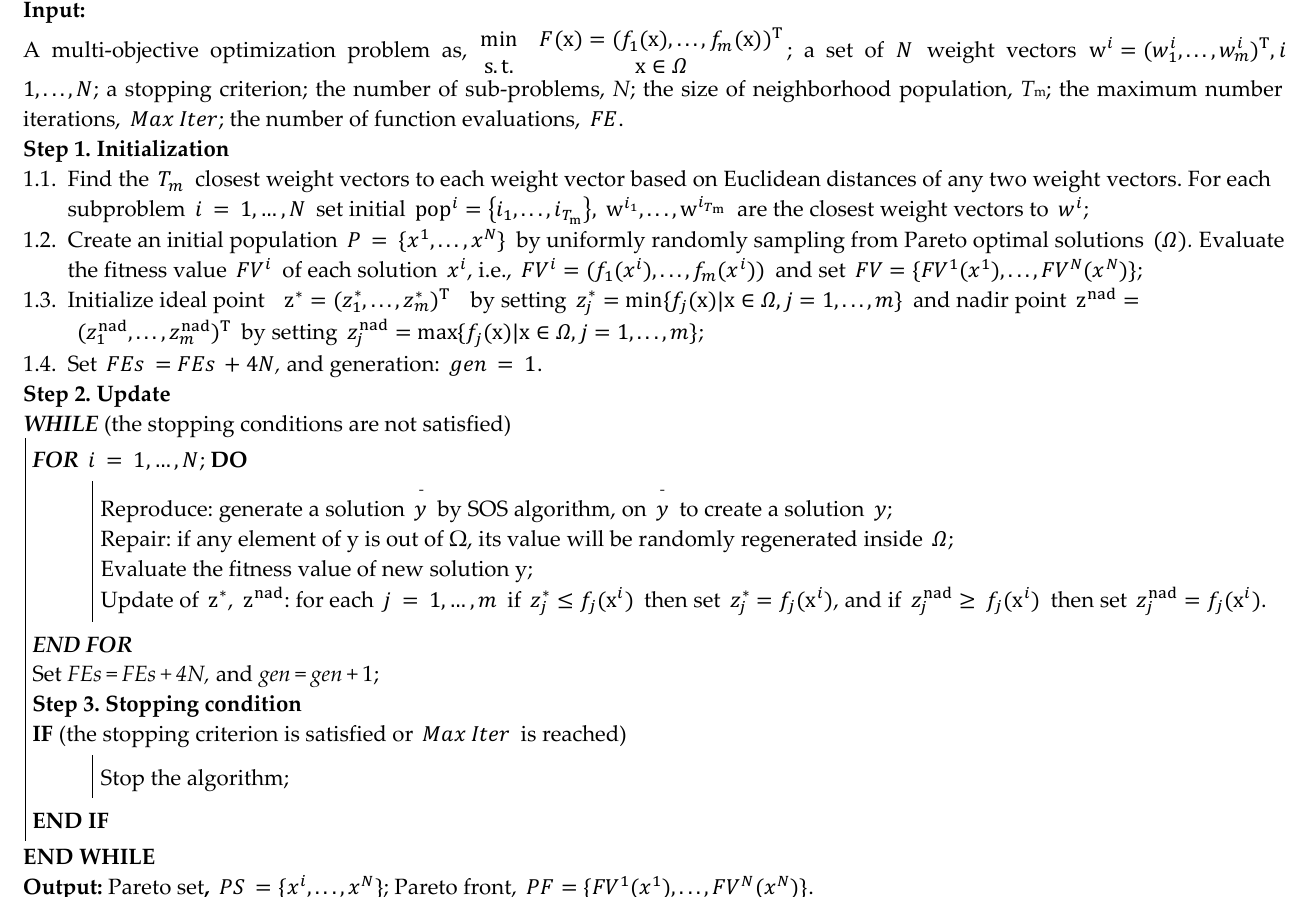
Algorithm 2: Pseudo-code of the MOSOS/D algorithm